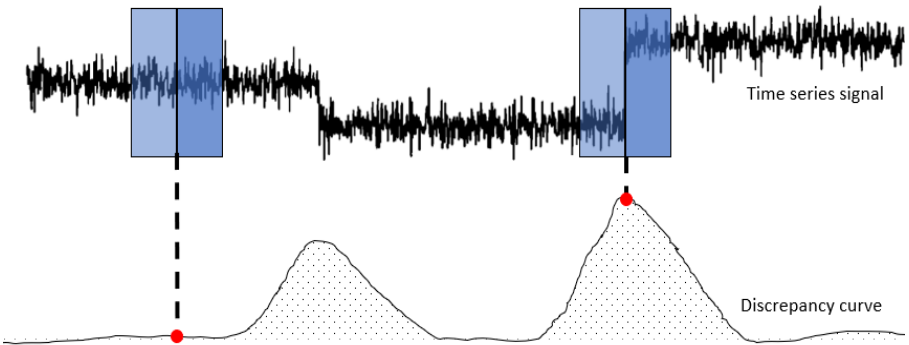
Figure 6. Sliding window approach: discrepancy curve based on [5].